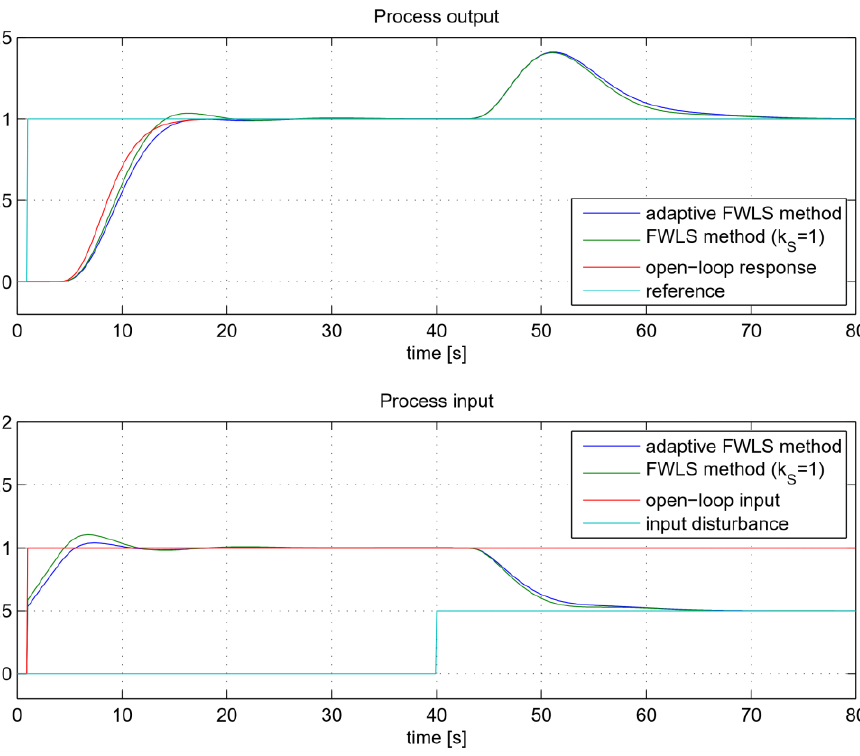
Figure 21. The closed-loop tracking and control signals for process G P 5 .